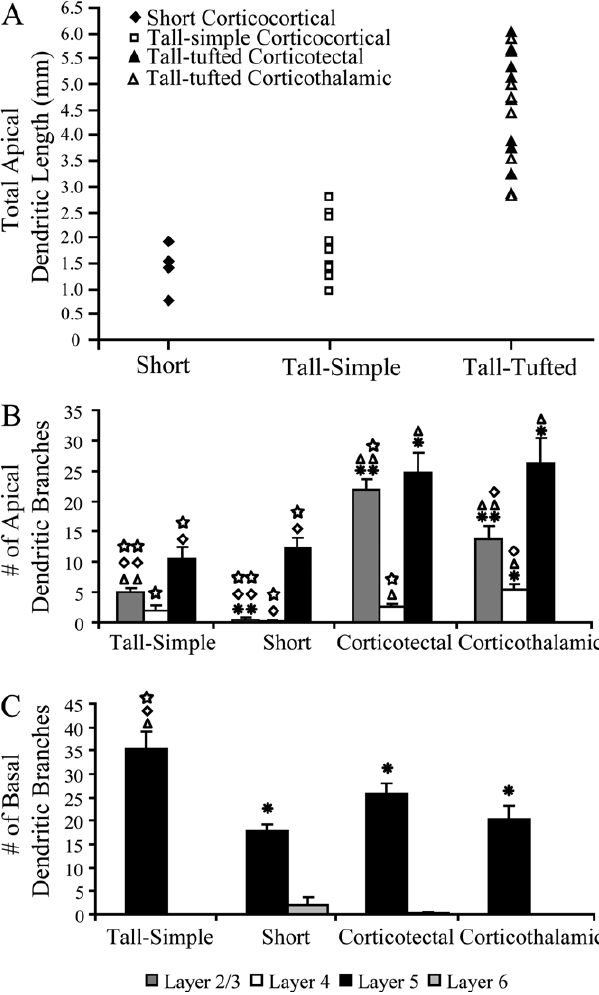
Figure 4. Distributions of total apical dendritic length for all layer 5 pyramidal neurons reconstructed, plotted by cell type. (A) The tall- tufted layer 5 pyramidal neurons have signifi cantly greater total apical den- dritic length than either the tall-simple or short layer 5 pyramidal neurons ( p < 0.001; t-test). Bar graphs indicate the number of apical dendritic branch points (B) and basal dendritic branch points (C) per cell in each cortical layer (mean ± SEM). Asterisks denote signifi cant difference from tall-simple neu- rons. Triangles denote signifi cant difference from short neurons. Diamonds denote signifi cant difference from tall-tufted corticotectal neurons.